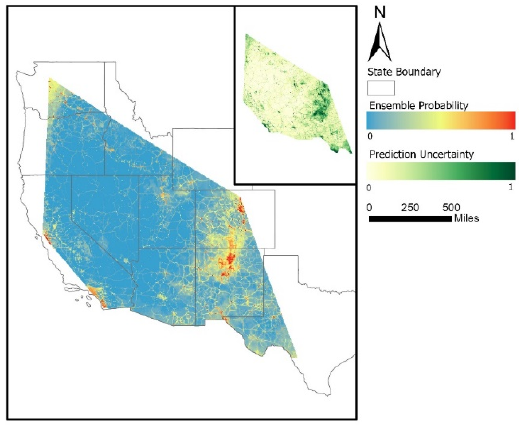
Figure 2. Spatial distributions of the predicted mortality events and the uncertainty in predictions for Wilson’s Warbler in the western and central United States in 2020.